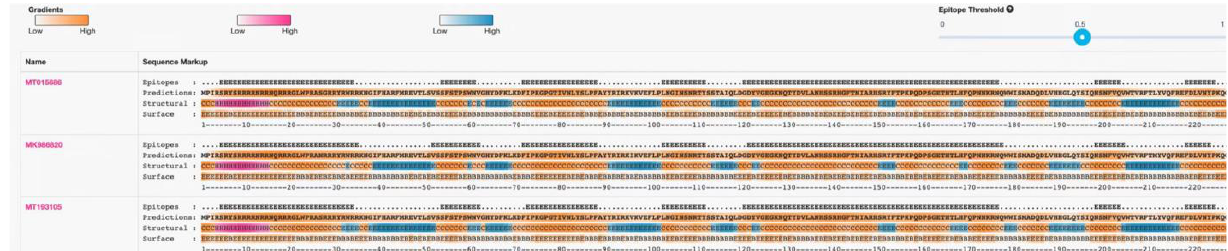
Figure 4. Prediction results for the B-cell epitopes, secondary structure, and surface position of some species’ genes. Epitope: Position above the epitope threshold. Prediction: Future protein sequences are shown in an orange gradient, indicating the BepiPred-2.0 prediction. Structure: helix (H-pink probability gradient), prediction table (E-blue probability gradient), and coil (C-orange probability gradient). Surface: buried (B)/exposure (E) and orange gradient illustrate the predicted relative surface accessibility. Three representative domestic strains are shown